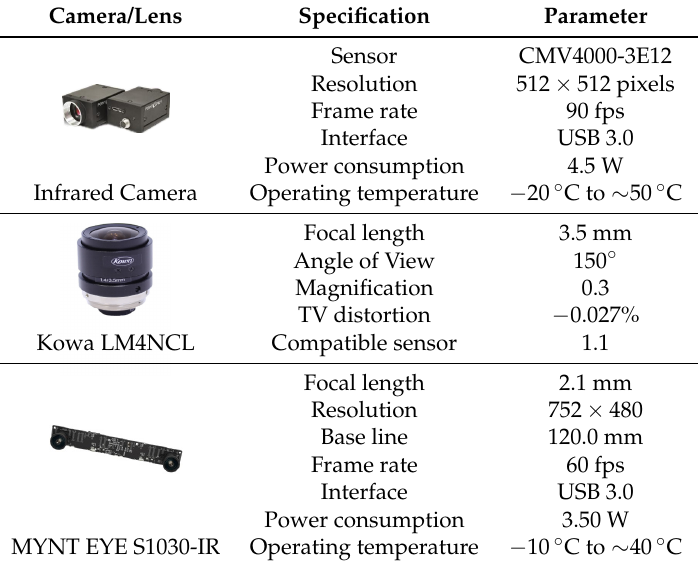
Figure 3. An overview of our landing system. This system contains two main parts: a hybrid camera array imaging module and a UAV autonomous landing algorithm module.The first part shows imaging using a fisheye lens camera and a stereo camera, which were employed to build our imaging system. In the second part, our UAV autonomous landing algorithm is presented, including a novel UGV state estimation algorithm and the design of the nonlinear controller in the system. Among them, the UGV state estimation algorithm performs detection and tracking, motion compensation, and the velocity observer function. Table 1. The camera and lens